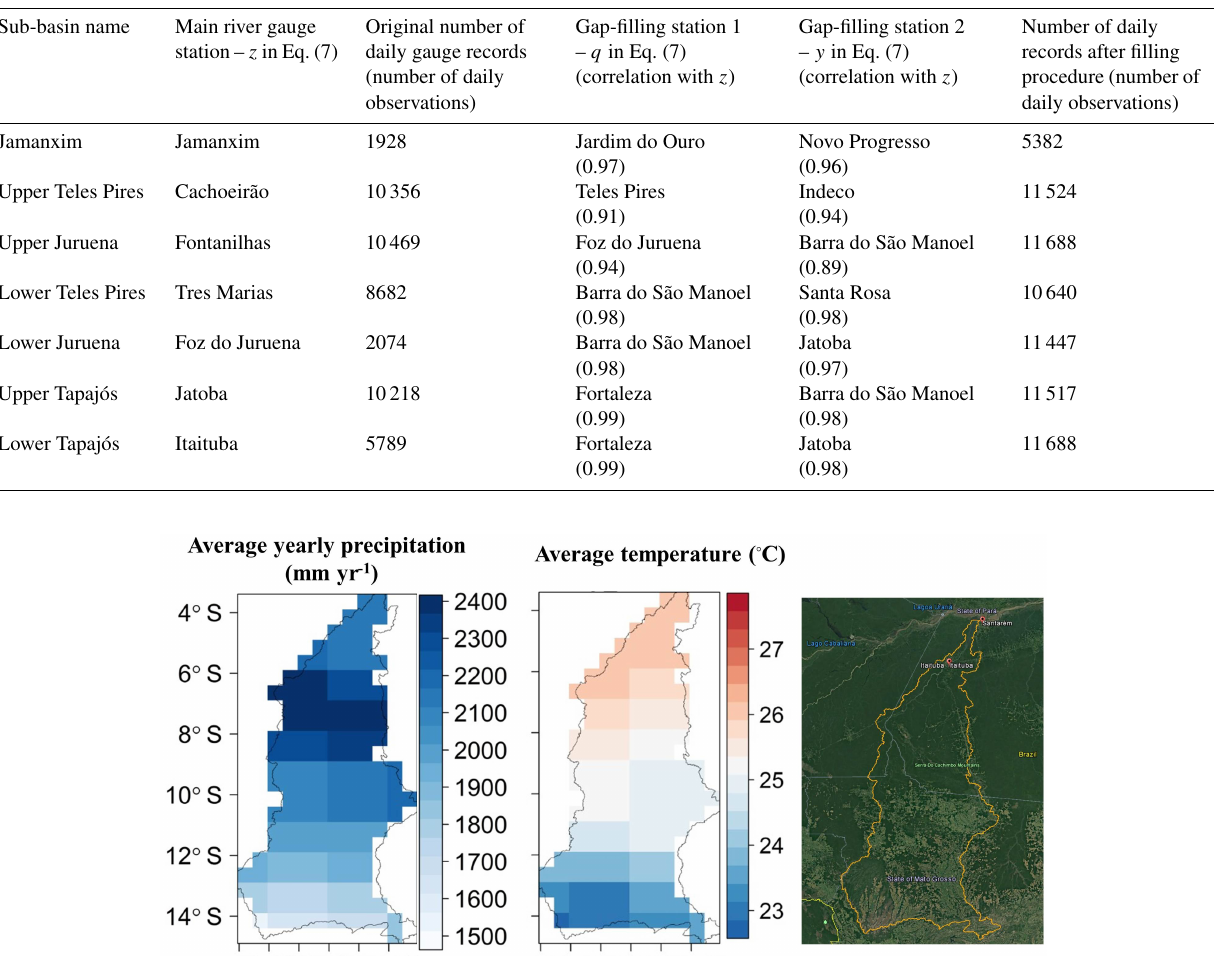
Table 2. Statistics about the gauge information filling procedure (correlation with the station to be filled, number of original observations, and filled number of observations).